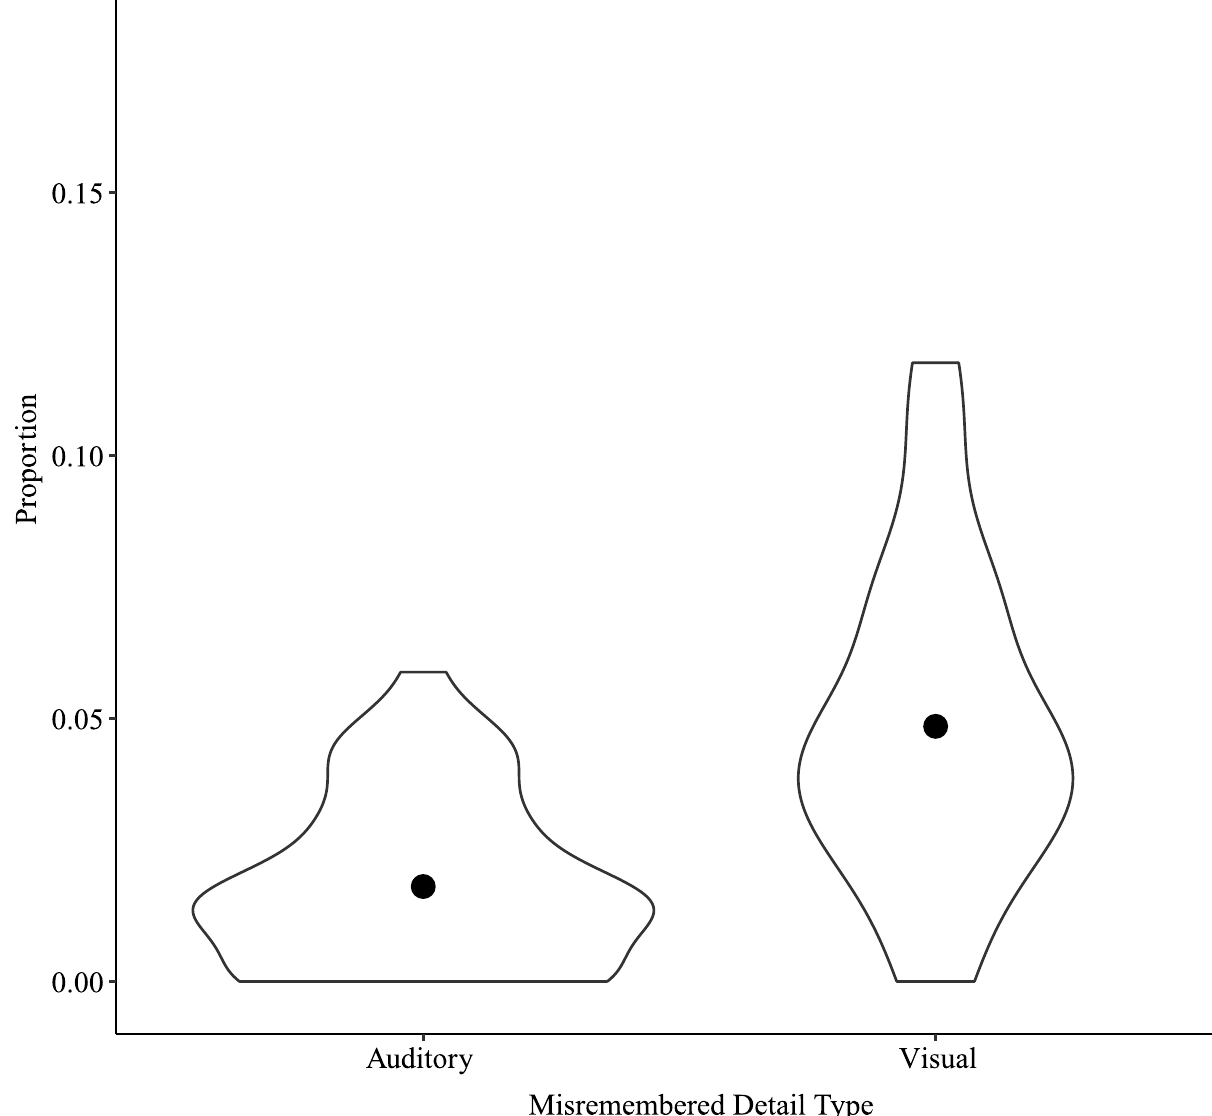
Fig 5. False recollections by Misremembered Detail Type for the Multimodal Narrative Condition in Study 1. Points show means for each Misremembered Detail Type in the Multimodal Narrative Condition. Note the y-axis scale, indicating very few false recollections.